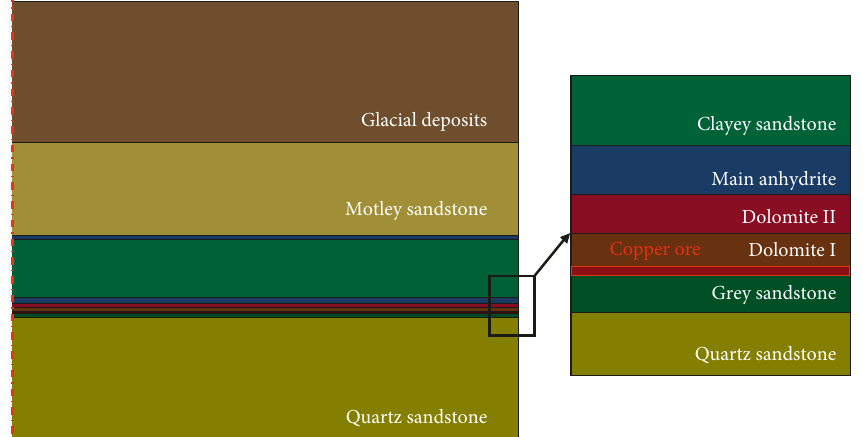
Figure 3: Geological layers in the considered area.